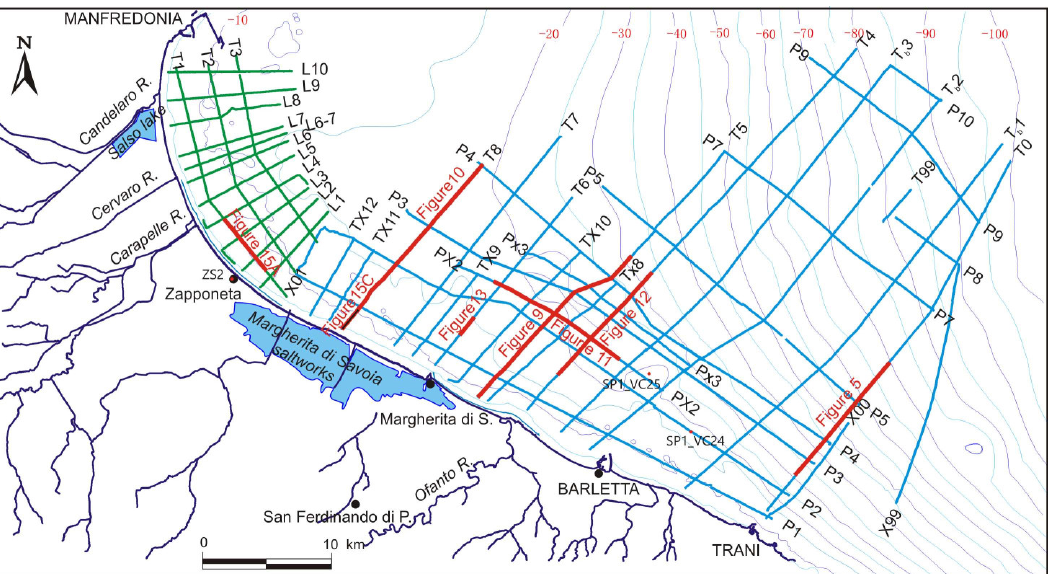
triangular interpolation method in GIS.